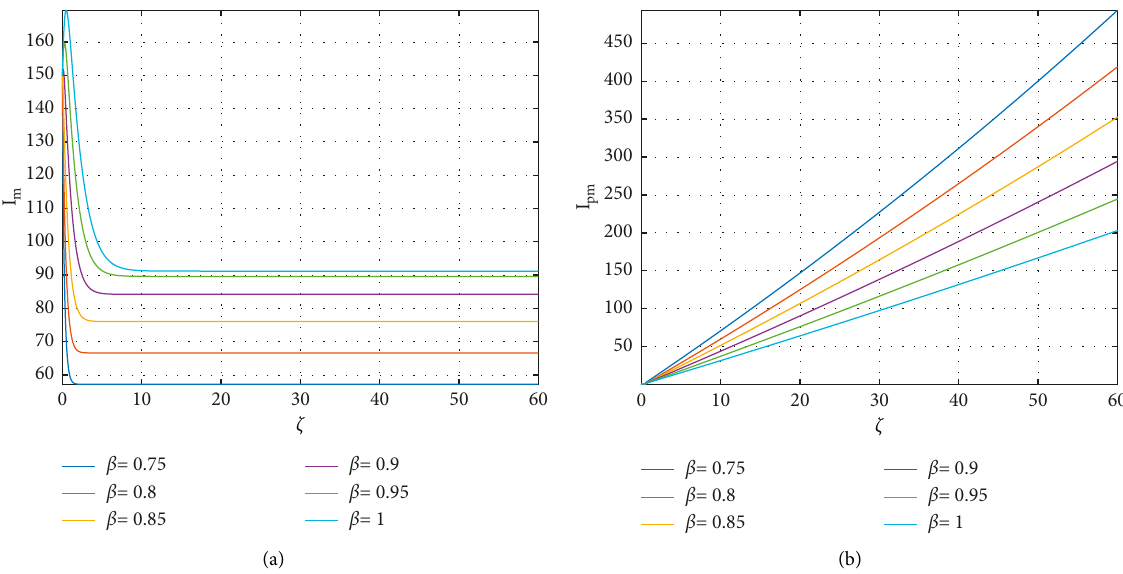
Figure 9: Two-dimensional illustration of the meningitis infectious I multiple fractional orders β ∈ [ 0 , 1 ]